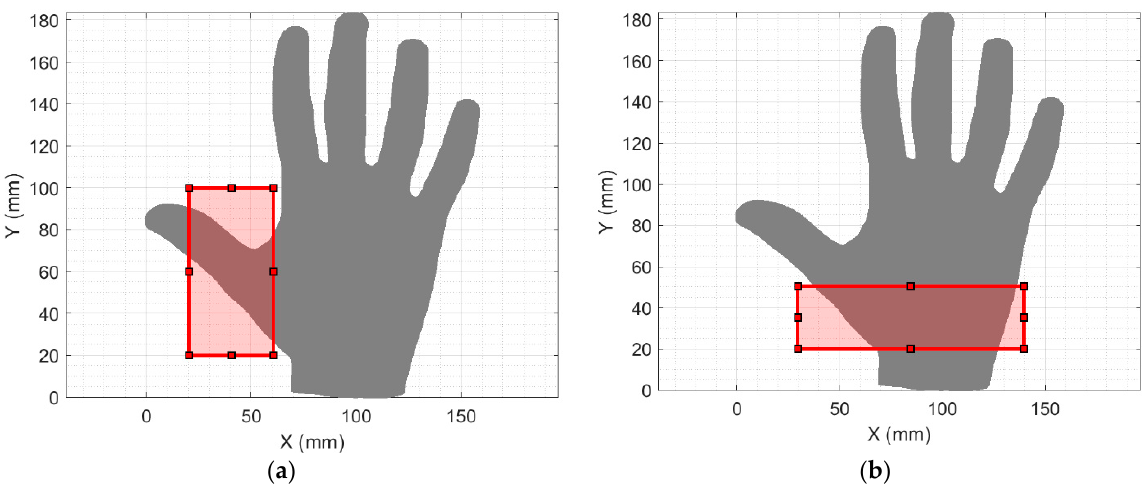
Figure 7. 2D view of the hand (this view allows us to see the palm of the hand) where two zones of interest are pointed out within red squares: ( a ) Zone 1; ( b ) Zone 2.